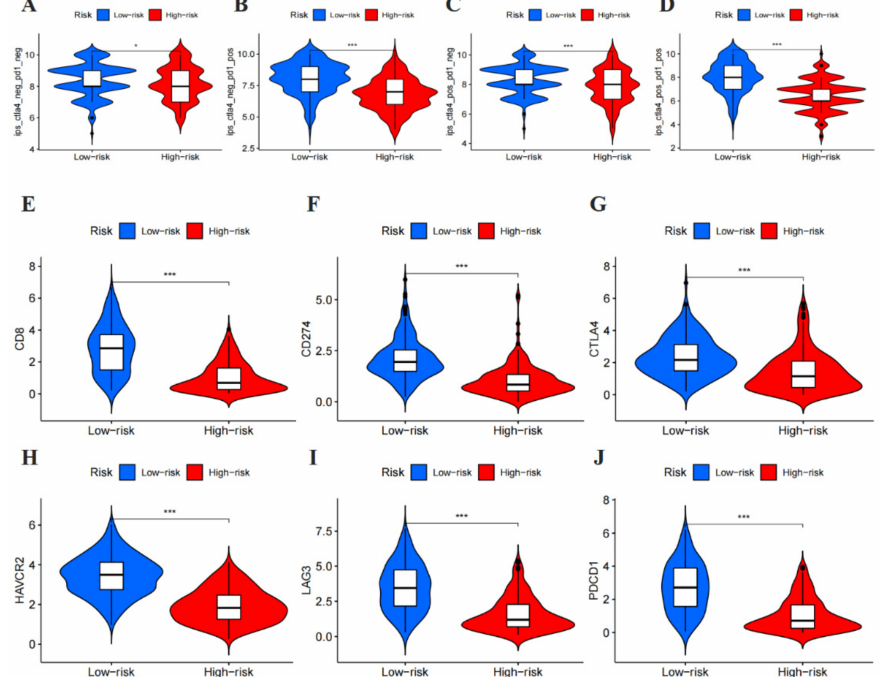
Figure 9. Immunosuppressed molecules and therapy associated with the signature-based risk score. ( A – D ) Immunophenoscore comparison between high-risk and low-risk groups in malignant melanoma patients in the PD-1 negative/positive or CTLA4 negative/positive groups. PD1 positive or CTLA4 positive represented anti-PD-1/PD-L1 or anti-CTLA4 therapy, respectively. ( E ) CD8, ( F ) CD274, ( G ) CTLA4, ( H ) HAVCR2, ( I ) LAG3, and ( J ) PDCD1 levels, the low-risk group was found to be positively correlated with upregulated, showed significant statistical difference in patients with melanoma. (* p < 0.05, *** p <